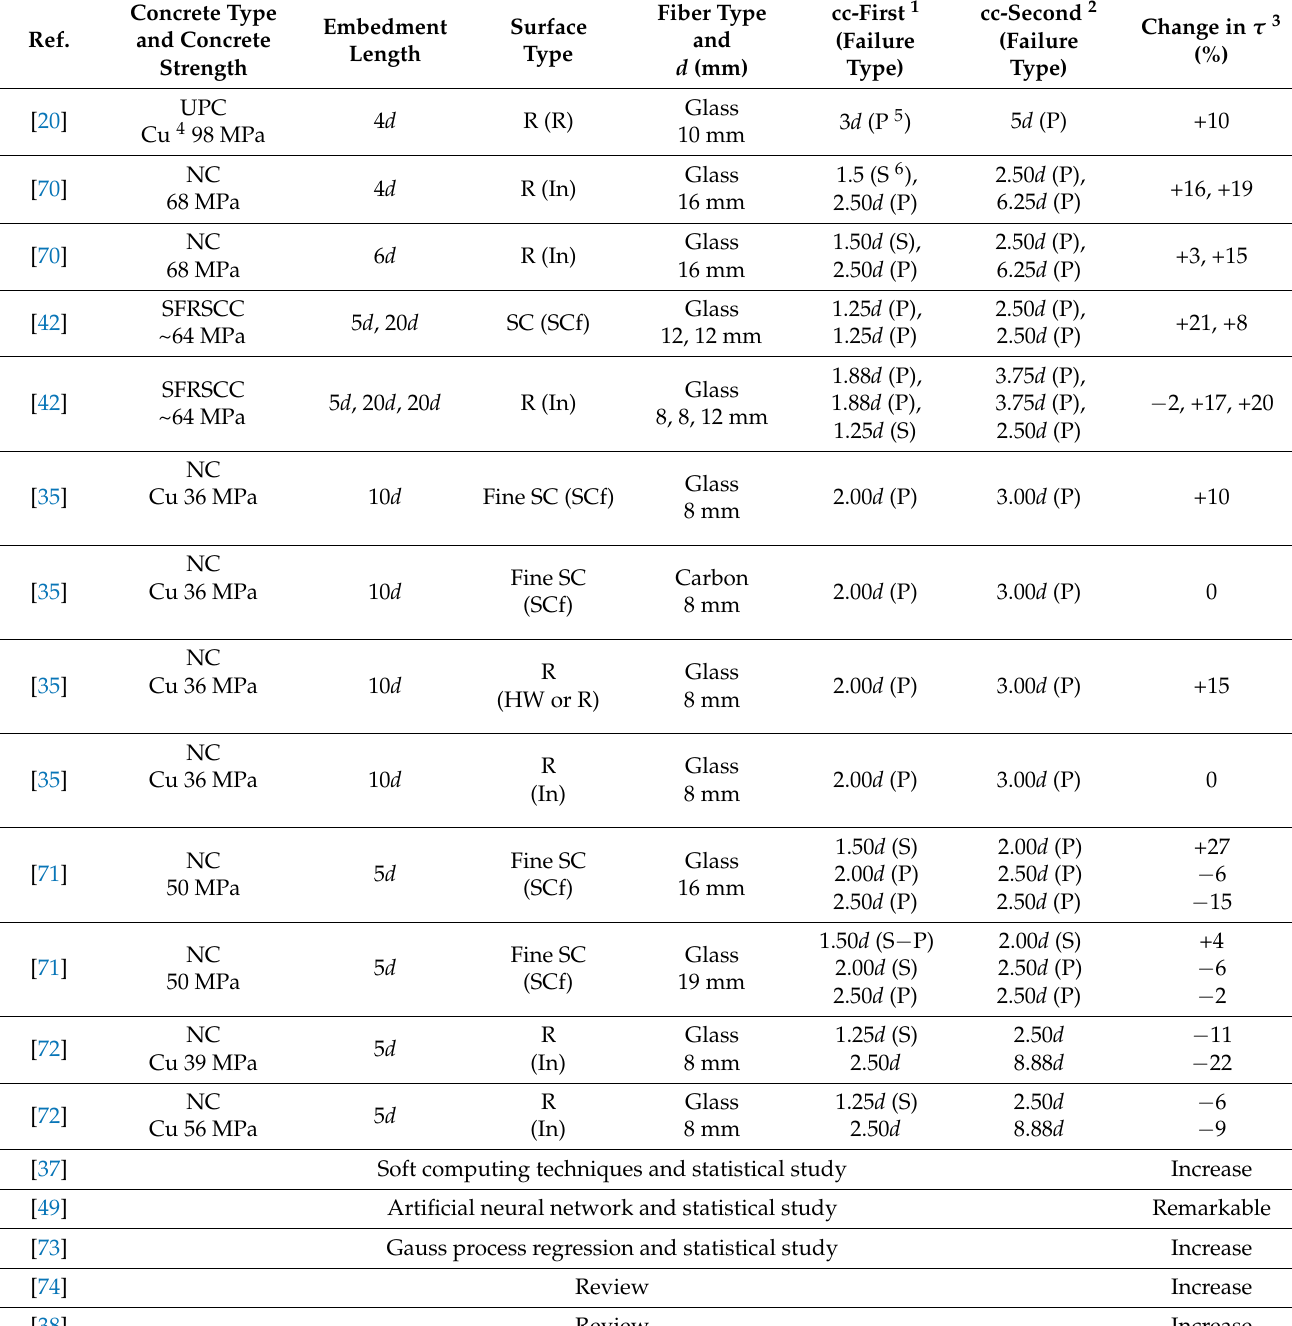
Table 4. Studies on the influence of concrete cover on FRP–concrete bond strength.